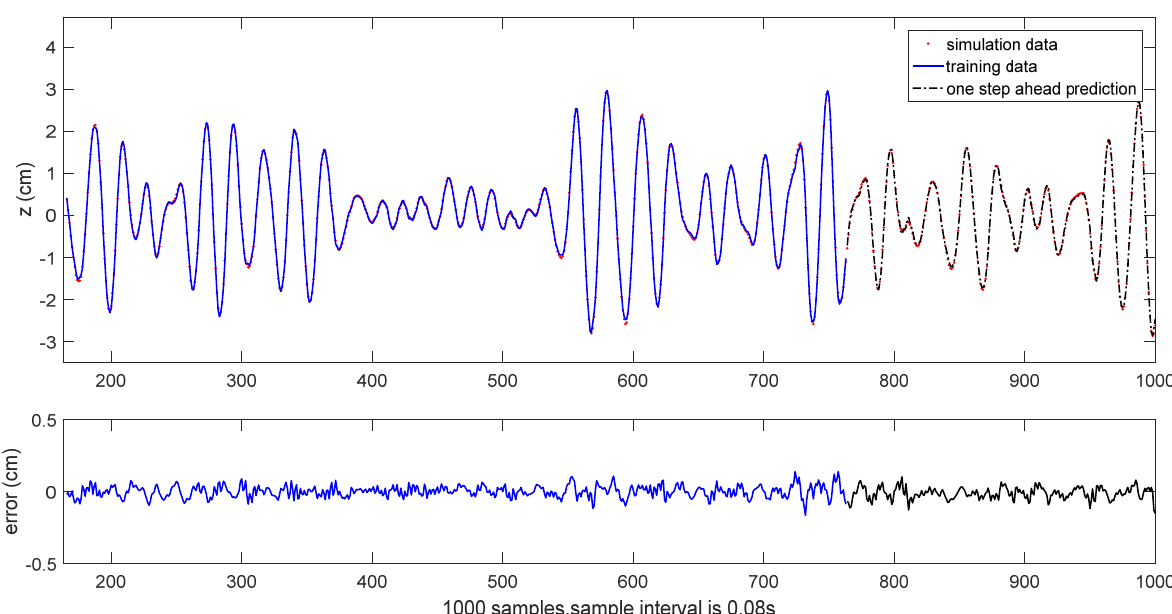
Figure 18. The one-step ahead prediction of heave motion in irregular waves at the instant k = 763 for the FPSO model.